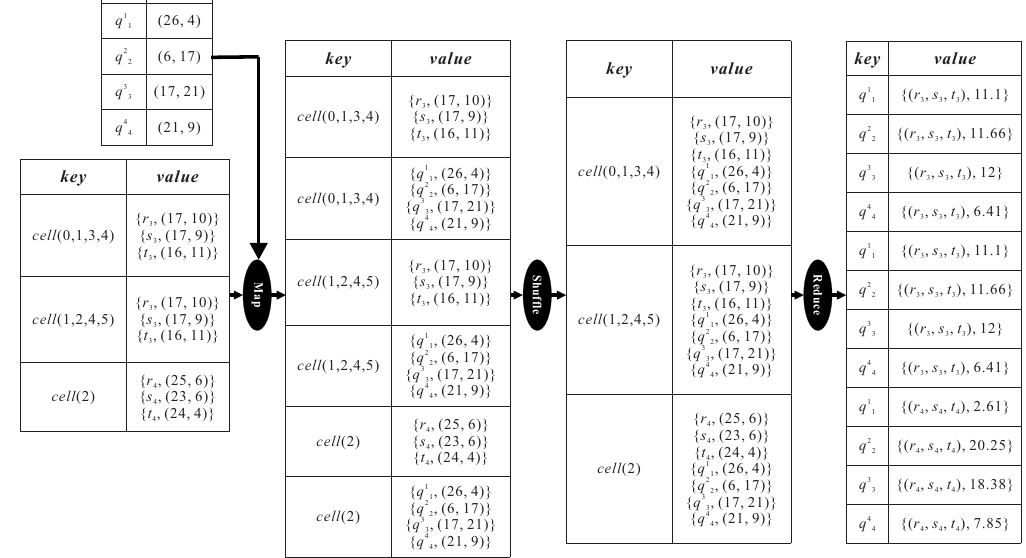
Figure 6. Illustration of the Aggregate-distance computing